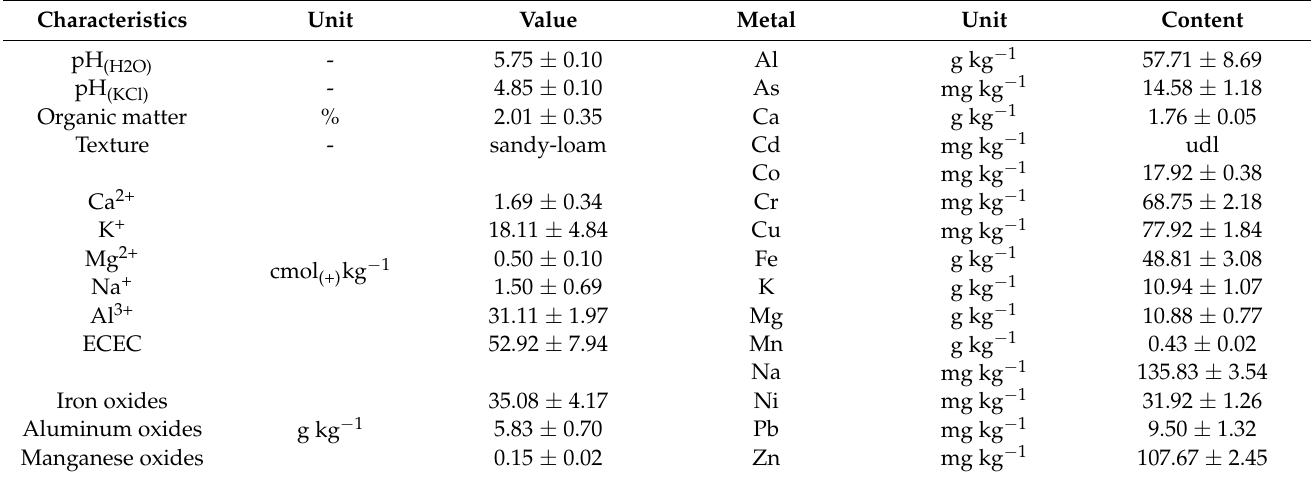
Table 1. Soil physicochemical